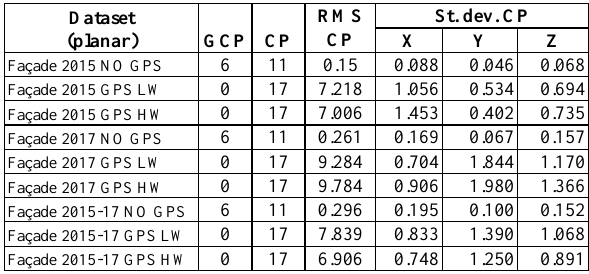
Table 5. Planar dataset: stats on residuals [m].